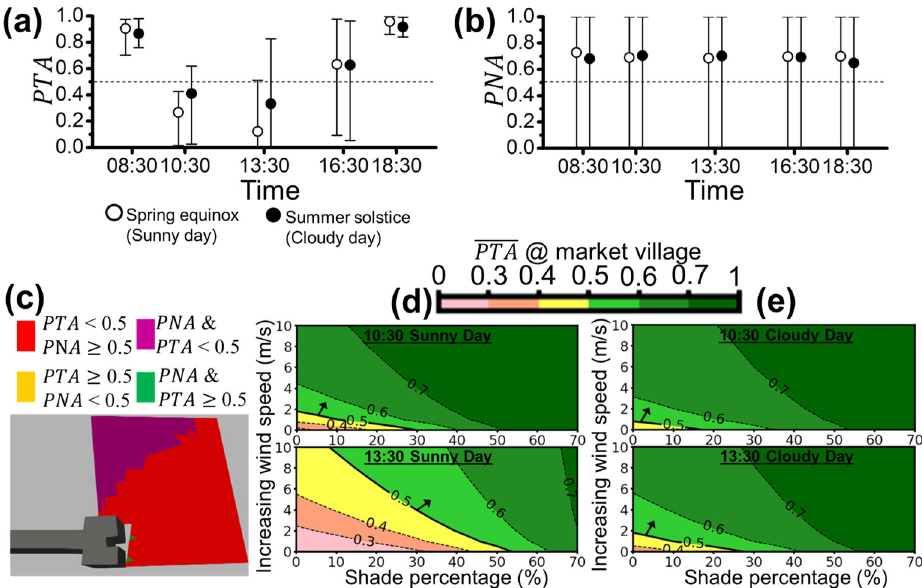
Fig 12. The area-averaged (a) PTA and (b) PNA of the market village (site (iv)) for both sunny (open circles) and cloudy (filled circles) days are represented with open and filled circles (i.e., PTA and PNA ), respectively. The error bars extended from the area-averaged PTA or PNA (circles) represent the local maximum and minimum PTA or PNA on the campus boulevard. The environmental acceptability threshold of 0.5 is denoted by the dotted line (i.e., PTA = 0.5 or PNA = 0.5). (c) The spatial plot of PTA and PNA above or below the threshold of 0.5 for market village at 13:30 on the sunny day (worst case) is illustrated. The contour plot shows the potential improvement of PTA with the increase in shade and/or wind speed at 10:30 and 13:30 on (d) the sunny day, and (e) the cloudy day for the market village.